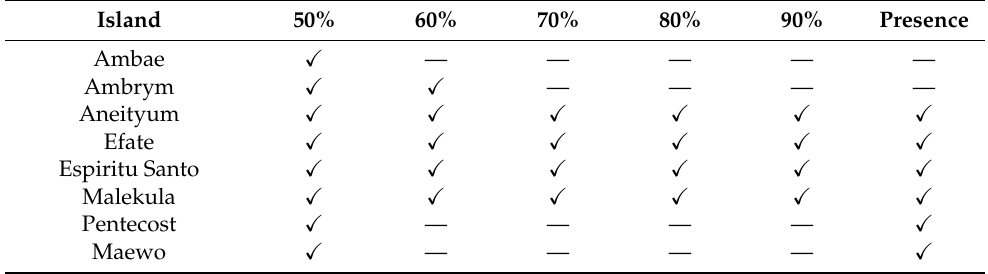
Table 1. Prediction of Vanuatubasis presence (50–90%) at different cut-offs above 50% for the 2018 model, compared to the results of 2019 fieldwork (Presence). Island 50% 60%